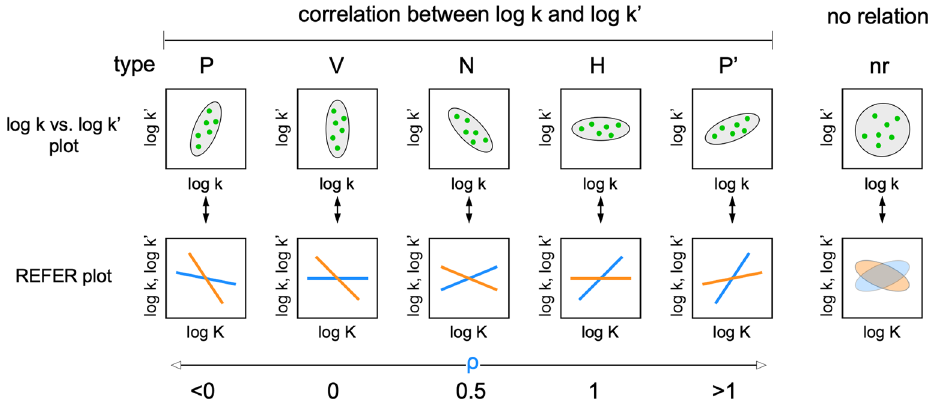
Figure 2. Relationships between log k and log k ′ as the basis of rbLFER. Several types are defined according to the data point distributions. Type N shows a negative correlation, and types V and H show flattened distributions of data points with zero correlations. The vertically flattened distribution provides two least-square lines with the slopes ρ of 0 (blue) and − 1 (orange), and the horizontally flattened distribution provides those with the slopes ρ of 0 (orange) and 1 (blue) in the REFER plots. Types P and P ′ are positive correlations between log k and log k ′ . Type nr has no relation between log k and log k ′ , and the REFER plot may show a weak, artificial correlation